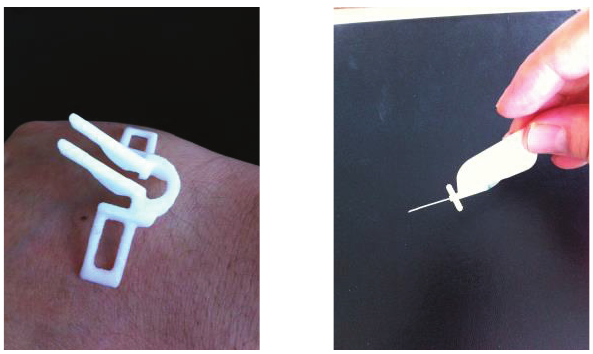
Figure 9 & 10: The S-guider & The GAv needle